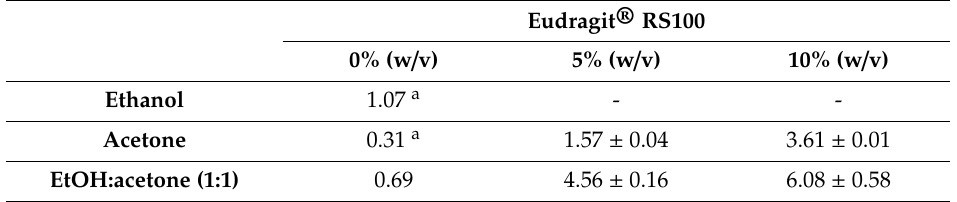
Table 3. Viscosity values ( η , mPa · s) at 20 ◦ C of solvents and polymeric solutions used in this